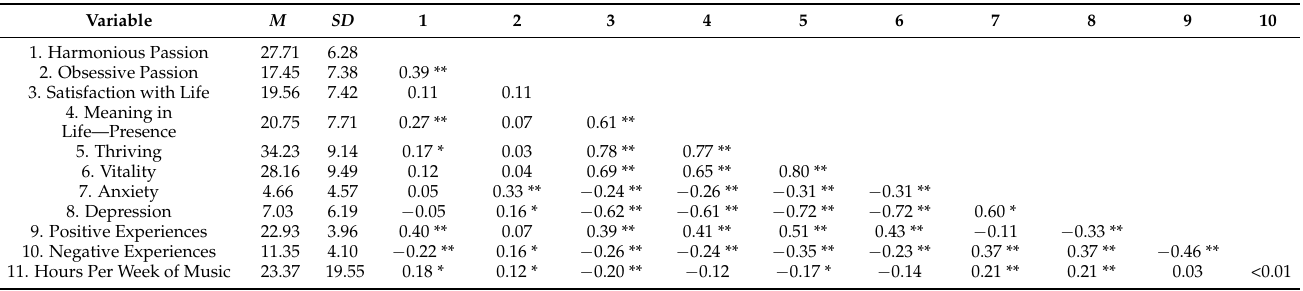
Table 1. Descriptive Statistics and Correlations for All Variables in the Study.